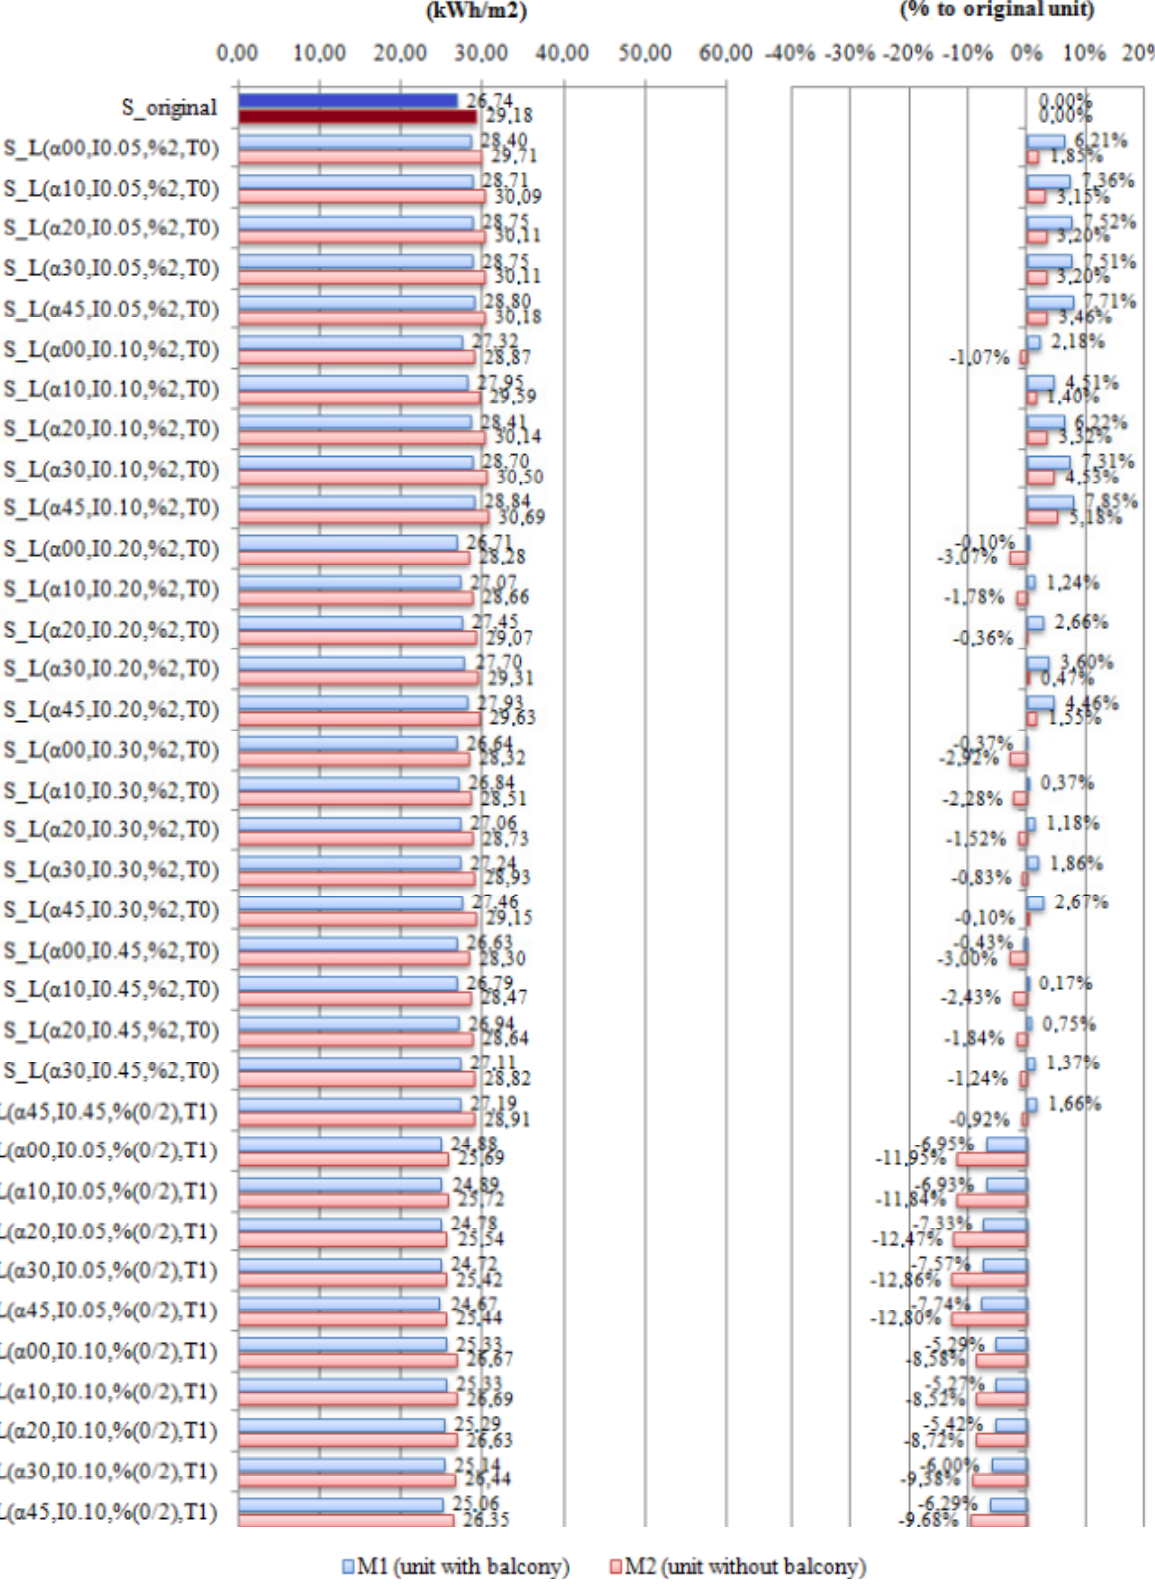
Figure A5. L Series: Annual thermal